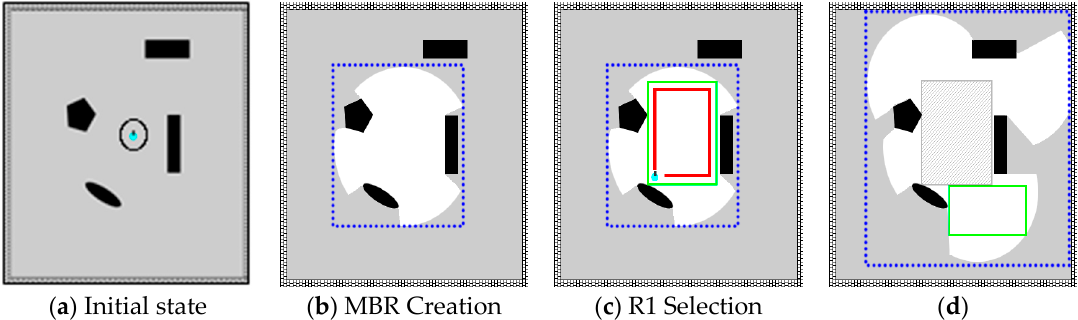
Figure 3. The Rmap building process in an unknown area. ( a ) The environment and robot (circle); ( b ) The environmental data obtained through sensing is the white area in the initial map setting, the unknown area is gray, the blue dotted box is the minimal bounding rectangle (MBR); ( c ) the new area is the white part obtained by moving along the red line of ( c ), the gray box is the updated R1 on the map, the blue dotted box is the MBR that contains all the information currently held, and the green box is the next R1 to explore; ( d ) Exploration.